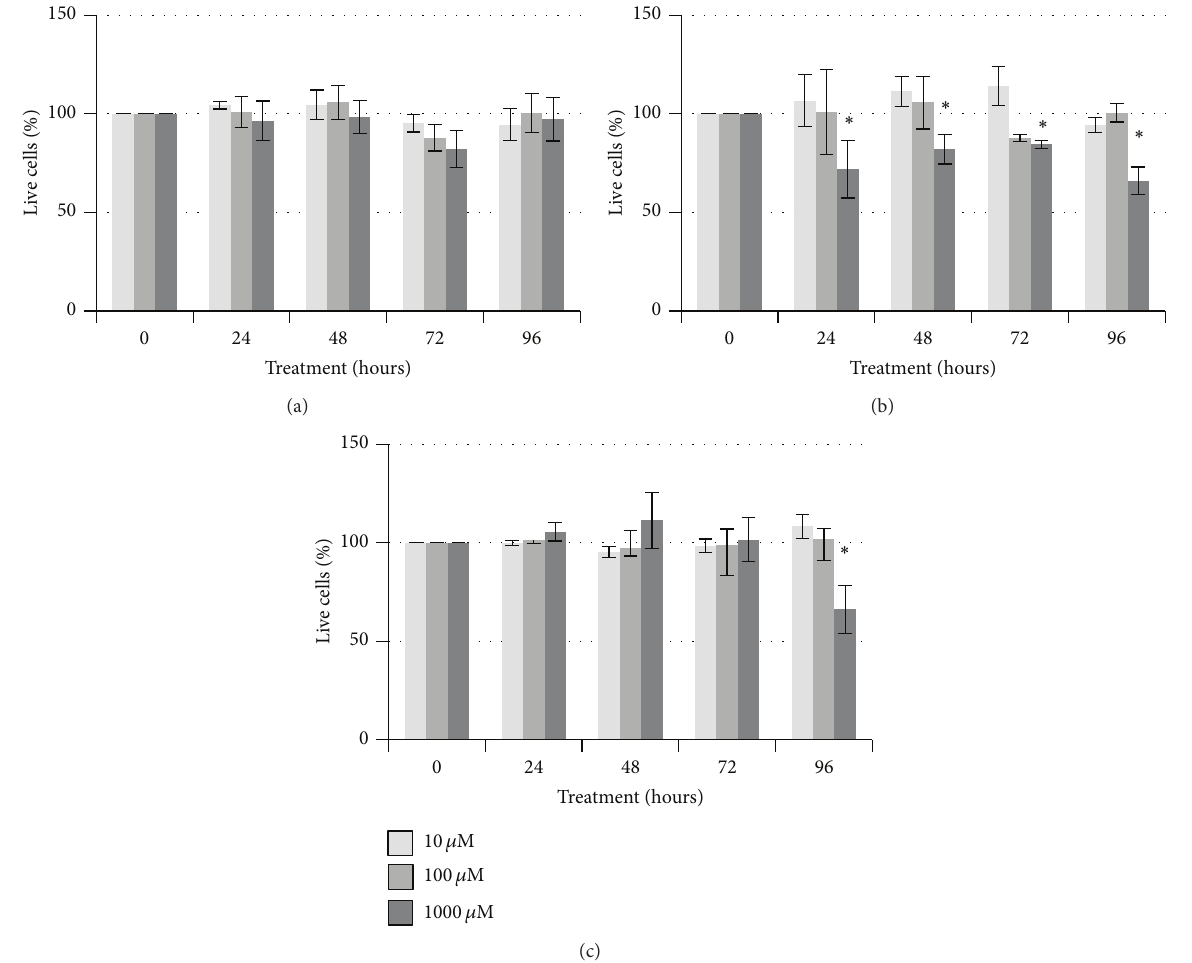
Figure 1: Viability of breast cancer cells after exposure to 10 𝜇 M, 100 𝜇 M, or 1000 𝜇 M cyclophosphamide. MDA-MB-231 (a), SK-BR-3 (b), or MCF-7 (C) cells were treated for up to 96 hours with either cyclophosphamide or a water control. Significant differences compared to the vehicle control ( ∗ 𝑃 < 0.05 ) are